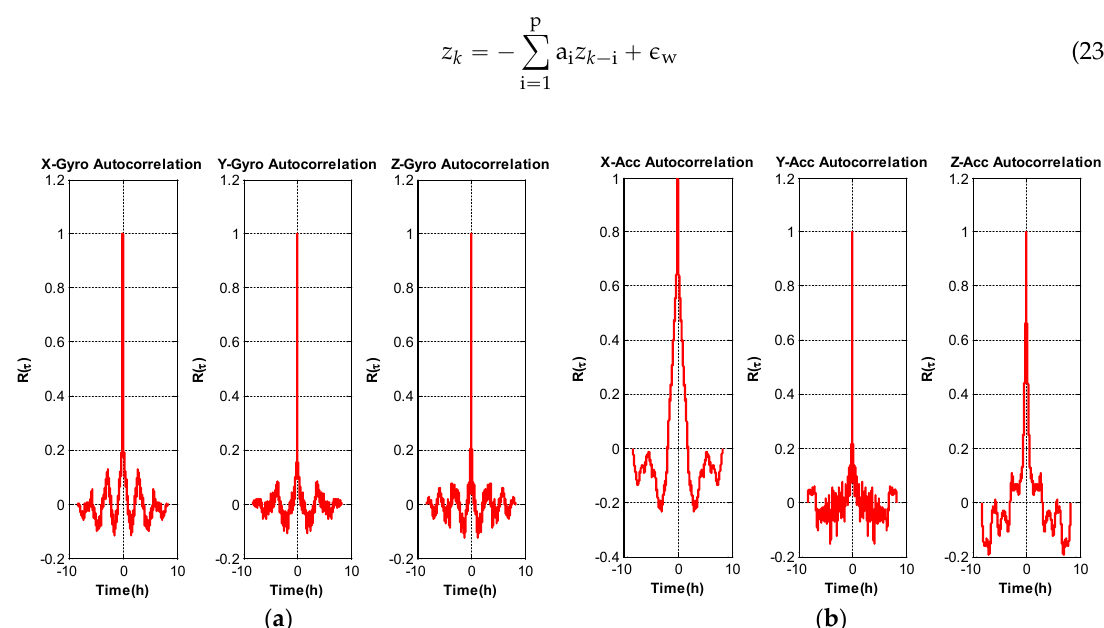
Figure 9. ( a ) Gyroscope autocorrelation results; and ( b ) accelerometer autocorrelation results.